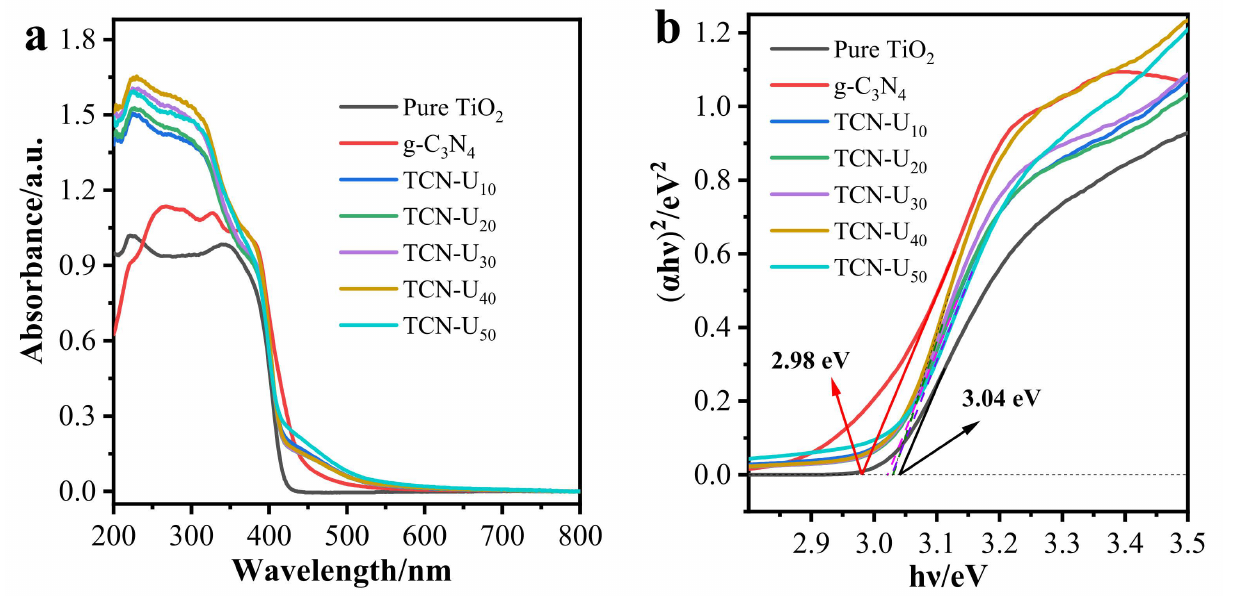
Figure 3. UV-Vis DRS spectra ( a ) and bandgap calculation spectra ( b ) of pure TiO 2 , g-C 3 N 4 and TCN-U x